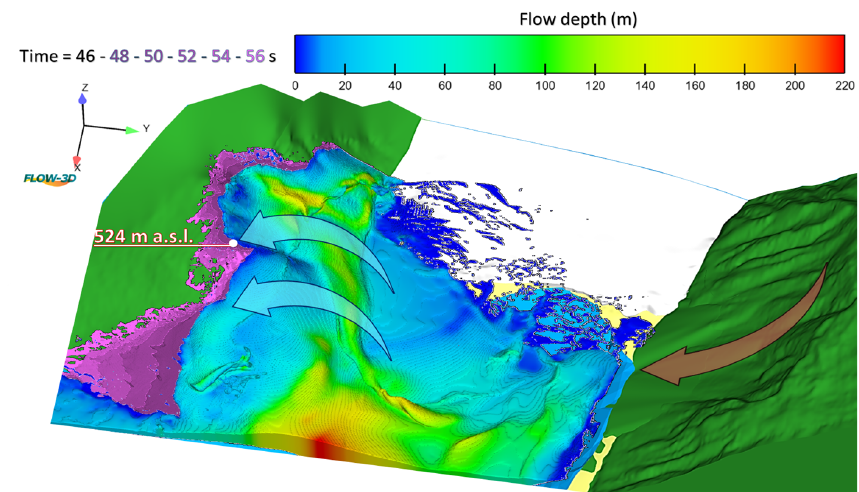
Figure 9. Impulse wave run-up on the opposite slope. At the 46s time step the wave reaches the maximum observed elevation of 524ma.s.l. (flow depth contours). A part of the wave body overtops the hill and proceeds on its path in a diagonal direction with respect to the slope gradient (shown by the different shades of purple for the time steps of 48, 50, 52, 54, and